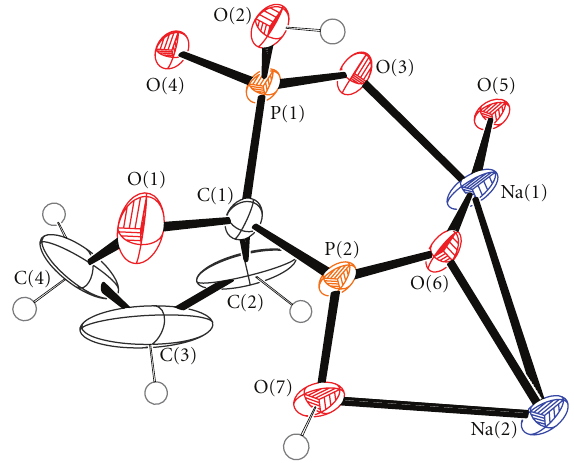
Figure 1: ORTEP representation of the main structural motif observed in Na 2 H 2 L. Ellipsoids are drawn at the 50% probability